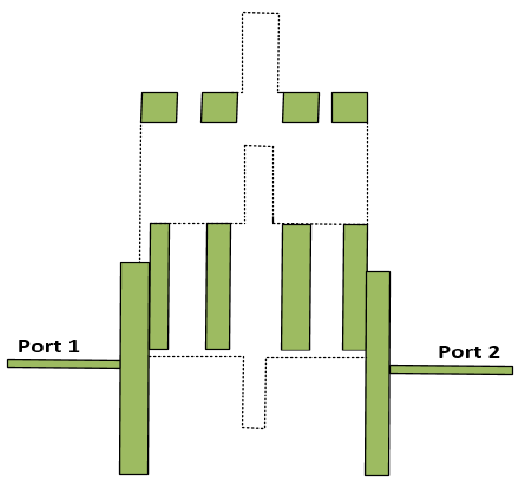
Figure 6. Microfluidically reconfigurable half-wavelength resonator filter. A microfluidic reconfigurable triple-band filter resonating at (1, 1.4, and 1.8) GHz